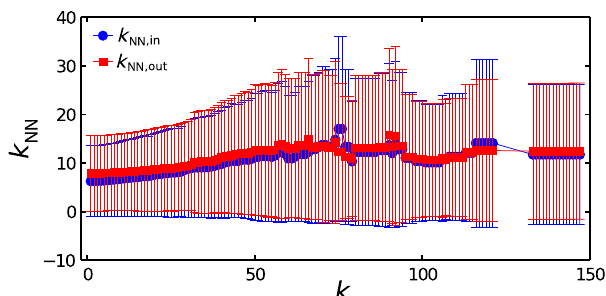
FIG. 10. Correlations between connectivity and influence net- works. A flat line indicates no correlations in the APS networks for h k NN i for the in-degree and h k NN i for the out-degree. In the degree sequence, there are no nodes with a degree around k ¼ 130